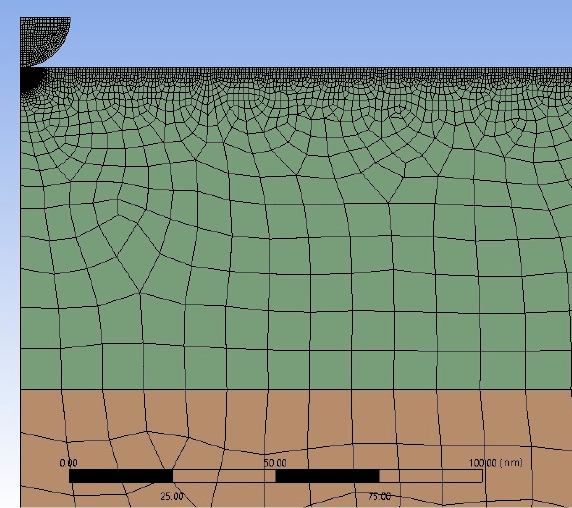
Figure 3. Fragment of the finite-element grid near the indenter. The scale bar is shown at the bottom of the figure.